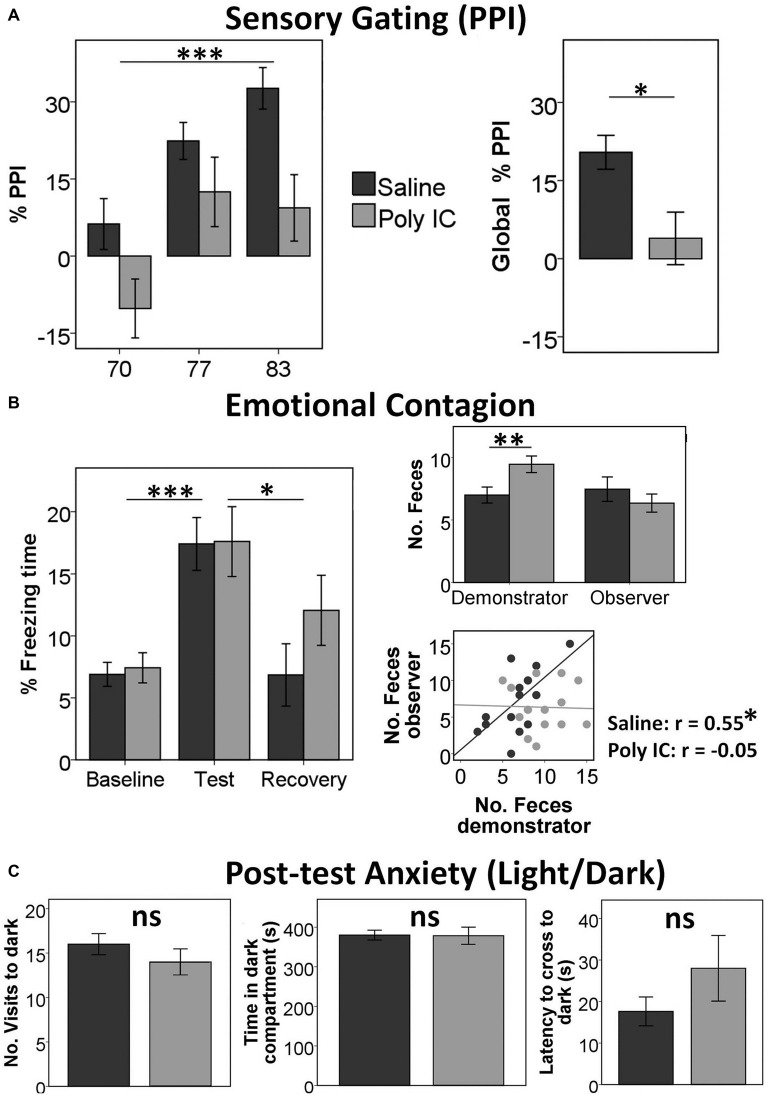
Offspring of polyinosinic-polycytidylic acid (Poly(I:C))-treated mothers show reduced sensory gating and almost intact social behavior. (A) Increased %pre-pulse inhibition (PPI) with increased pre-pulse intensity in both groups (left) and reduced Global %PPI in Poly(I:C) offspring (right). (B) Freezing (fear-like) behavior in both groups is increased in the test period when the demonstrator is receiving shocks compared with the baseline and the recovery periods (left); wild-type (WT) demonstrators deposit more feces when observer is Poly(I:C) offspring (right). (C) No differences in any parameter in the light/dark test measuring anxiety-like behavior in observers after the emotional contagion test. Graphs illustrate Mean ± SEM. *p < 0.05, **p < 0.01, ***p < 0.001.